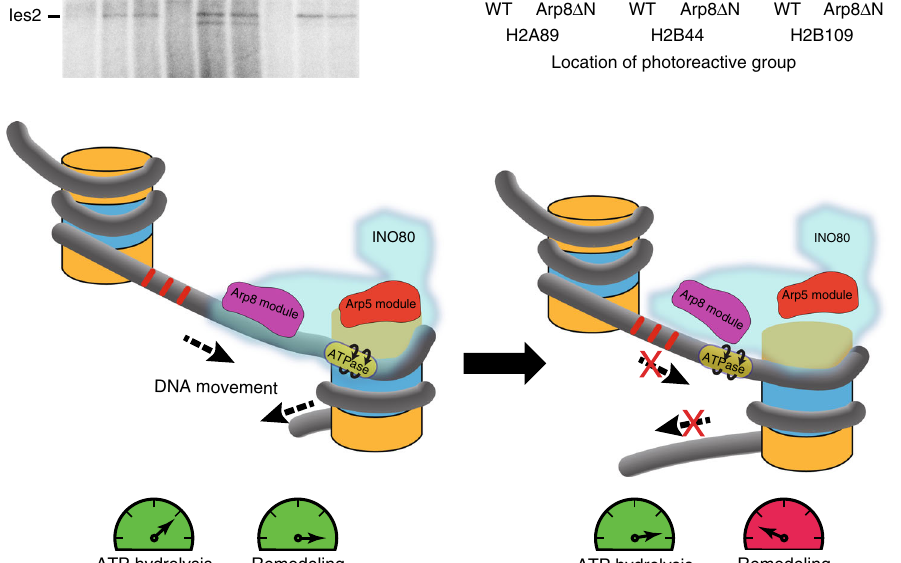
Fig. 4 Arp5 interactions with the acidic pocket of the histones H2A-H2B dimer requires Arp8 and Arp4 binding to extranucleosomal DNA. a Locations of the aspartate (D) and glutamate (E) residues constituting the acidic pocket on histone H2A-H2B dimer surface are highlighted in red 31 . The sites of the modi fi ed cysteine residues used to map histone interactions of wild type and Arp8 Δ N INO80 are shown as black spheres. b – d Phosphorimages of INO80 subunits tagged by crosslinking and [ 125 I] radiolabel-transfer. Crosslinked Arp5, Ino80, and Ies2 subunits are indicated on the left. c Crosslinked Arp5 was distinguished from co-migrating Ies1 using INO80 with C-terminally HA-tagged Arp5 (Arp5-HA). d The crosslinking patterns of wild type and Arp8 Δ N INO80 are compared. e Plots showing the crosslinking ef fi ciencies of wild type and Arp8 Δ N INO80 to the H2A-H2B dimer surface. Values are mean of three experiments, normalized to the Ino80 subunit of wild type at H2B44. Error bars denote ± s.d. f The role of the Arp8 module in regulating INO80 chromatin remodeling in a linker DNA-length dependent manner is illustrated. The Arp8 and Arp5 modules are depicted along with the ATPase domain of Ino80, all as a part of the INO80 complex. As nucleosomes are moved closer together, binding of the Arp8 module to linker DNA is disrupted, which in turn causes the Arp5 module to lift off from the histone dimer surface and the ATPase domains moves away from the core nucleosome. These conformational changes uncouple the ATP hydrolysis from the nucleosome mobilization activitiy of